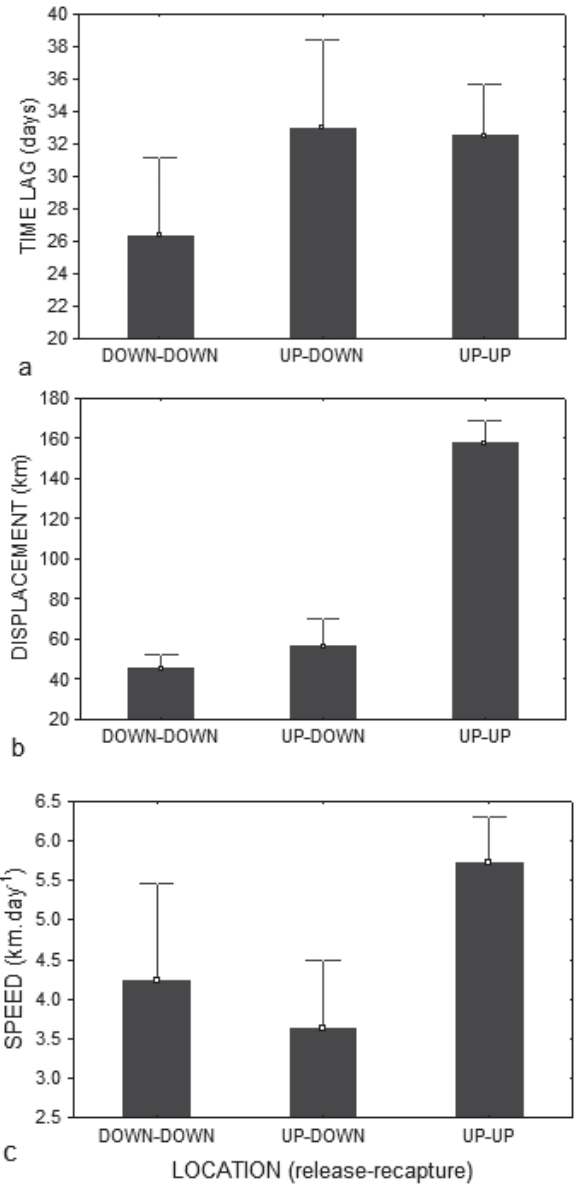
Fig. 2. Mean (±SE) of release-recapture time lag (a), distance traveled (b) and speed developed (c) by individual curimba Prochilodus lineatus in the Upper Paraná River region, tagged and released downstream (Down) and upstream (Up) from the Porto Primavera Dam. Location indicates, respectively, the “release point – recapture point” in relation to the Porto Primavera